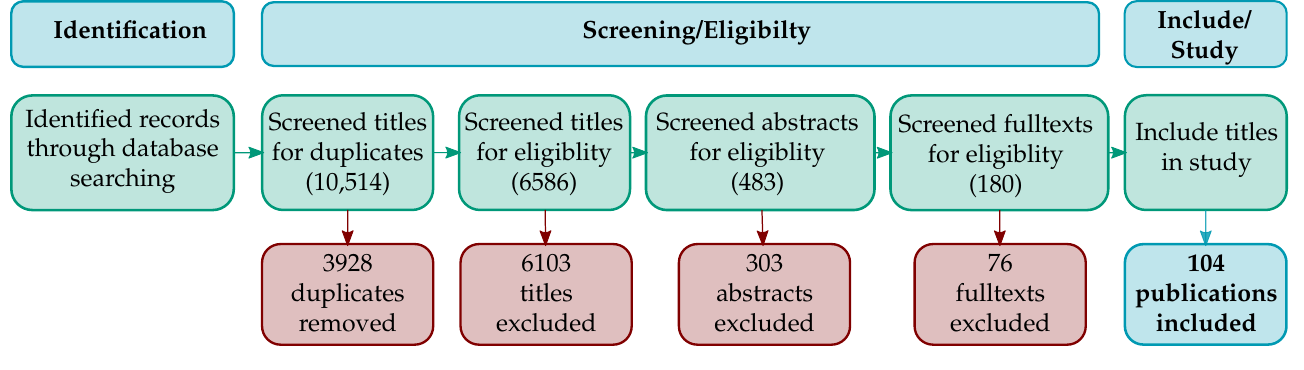
Figure 2. Results of literature